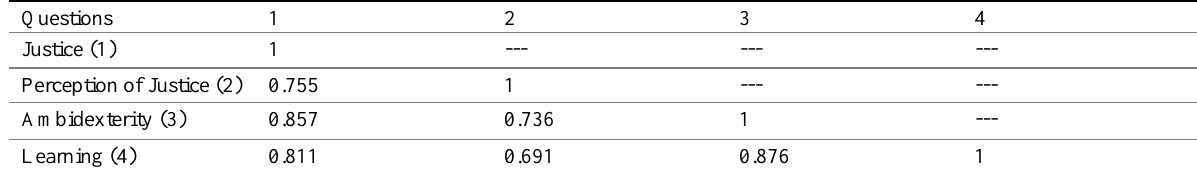
Table 4: Correlation Table (Latent Variable Correlations)